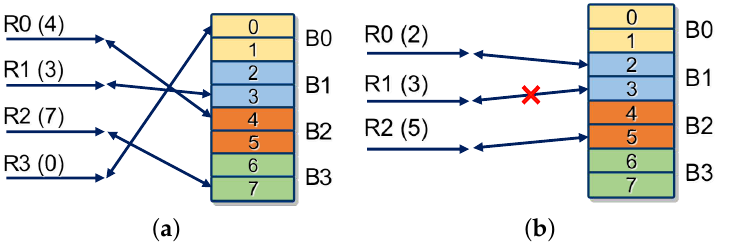
Figure 7. The access mode of the multiport hash table of HybriDC. ( a ) Normal parallel access, ( b ) access